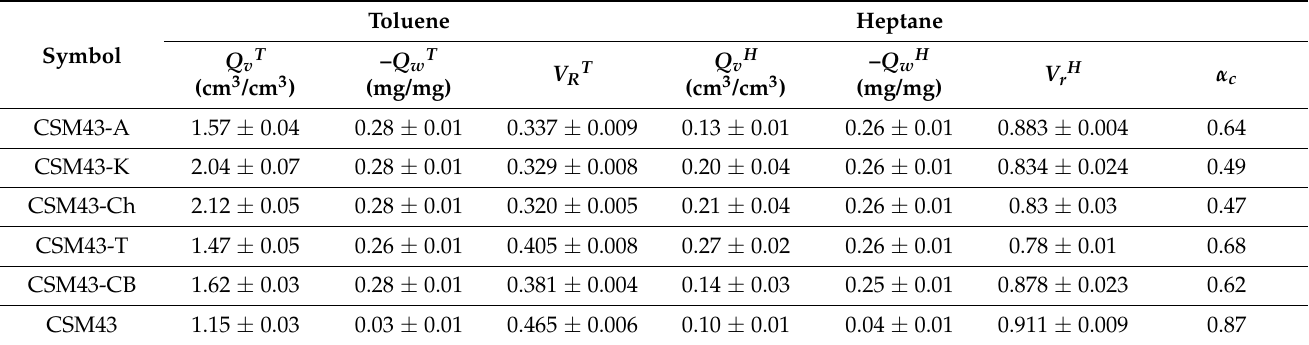
Table 7. Values of equilibrium swelling of filled CSM43 vulcanizates; T = 160 ◦ C, t v = 5–15